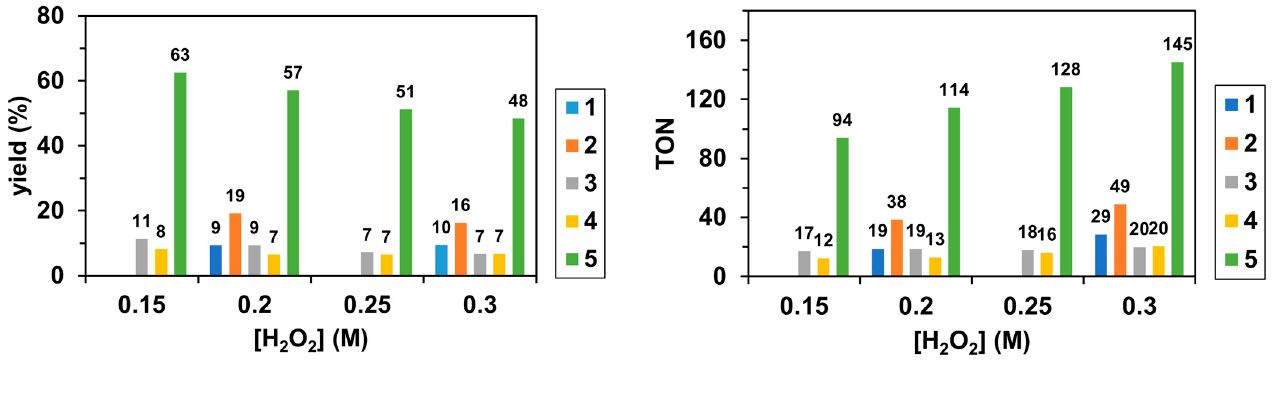
Figure 7. Comparison of the catalase-like activity of [Fe II (L 1 -L 5 )] 3 ](CF 3 SO 3 ) 2 ( 1 – 5 ) complexes at 298 K. ( a ) Dependence of the reaction yield on the H 2 O 2 concentration. ( b ) Dependence of the TON (TON = [H 2 O 2 ]/[ 1 – 5 ] on the H 2 O 2 concentration (Table 2).